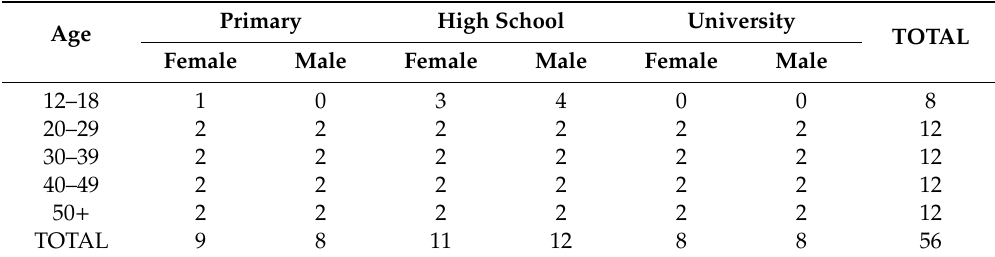
Table 1. Sample of Santomeans for data, by age, education level, and